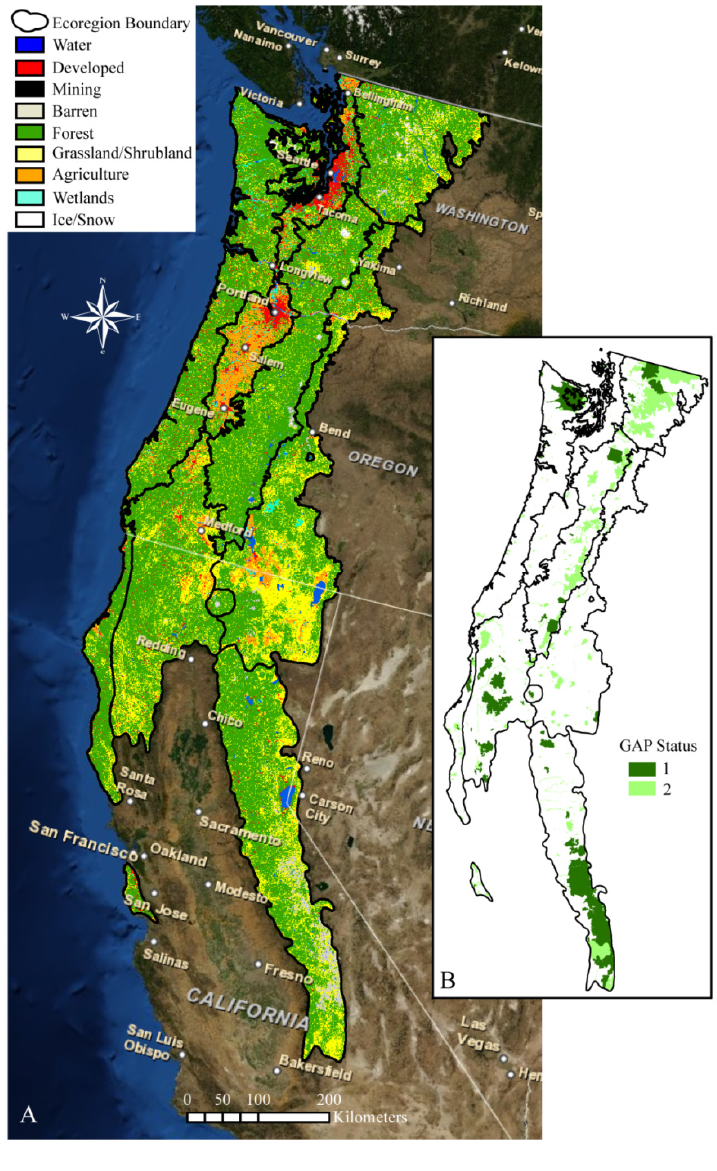
Figure 3. ( A ) The Pacific Northwest land use and land cover (LULC) in the year 2000 based on the harmonized land cover dataset described in Section 3.3. Basemap satellite data copyright © ESRI, DeLorme, NAVTEQ, TomTom; ( B ) Protected areas in the Pacific Northwest with GAP Status 1 (dark green) and 2 (light